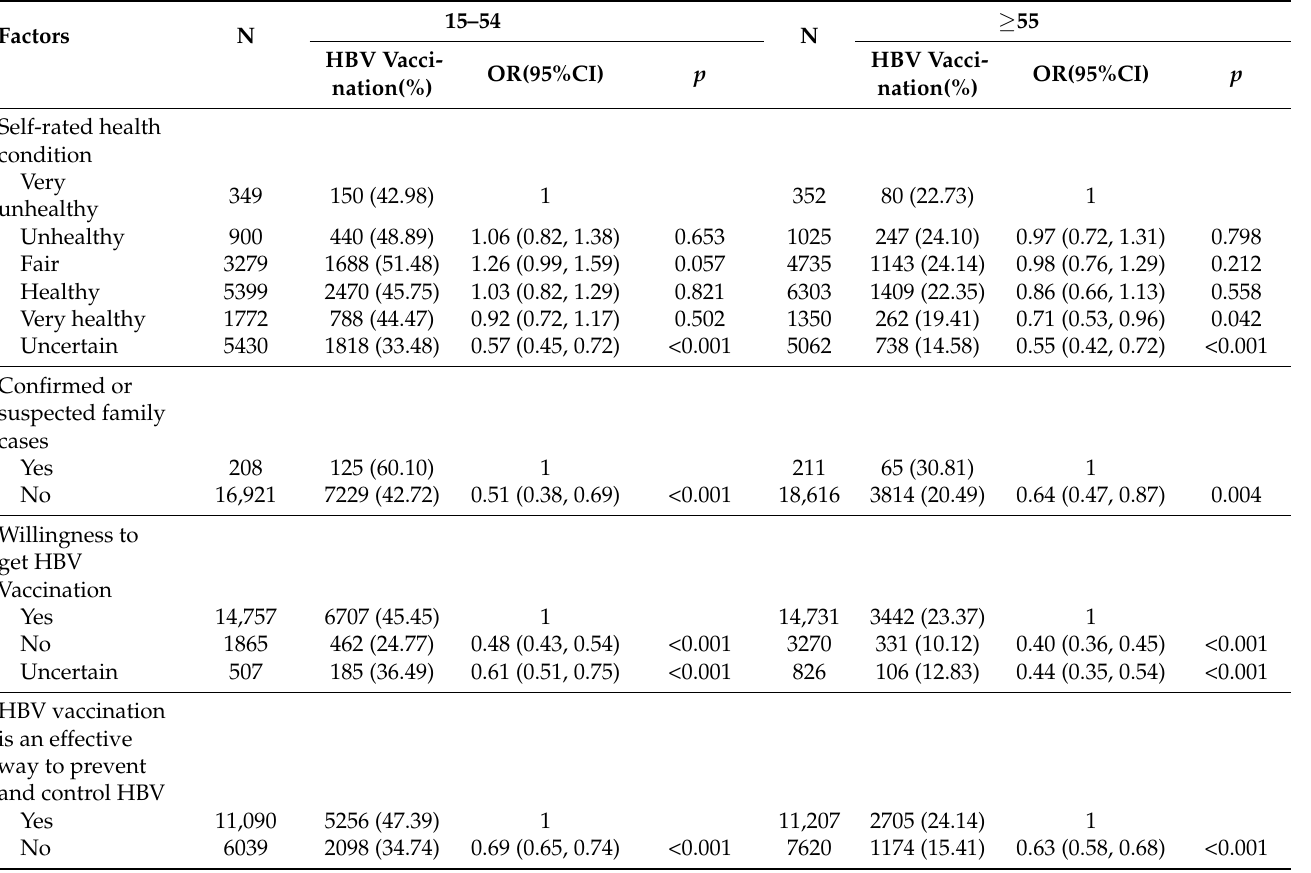
Table 3. Associations between related factors and HBV vaccination coverage rates stratified by age group *.